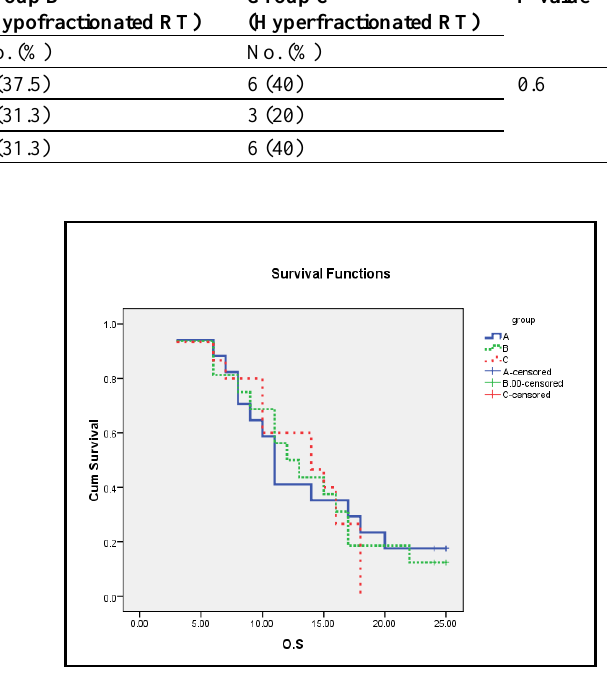
Figure 2: Overall survival (OS) in months by treatment group (group A: conventional RT, group B: Hypofractionated RT & group C: